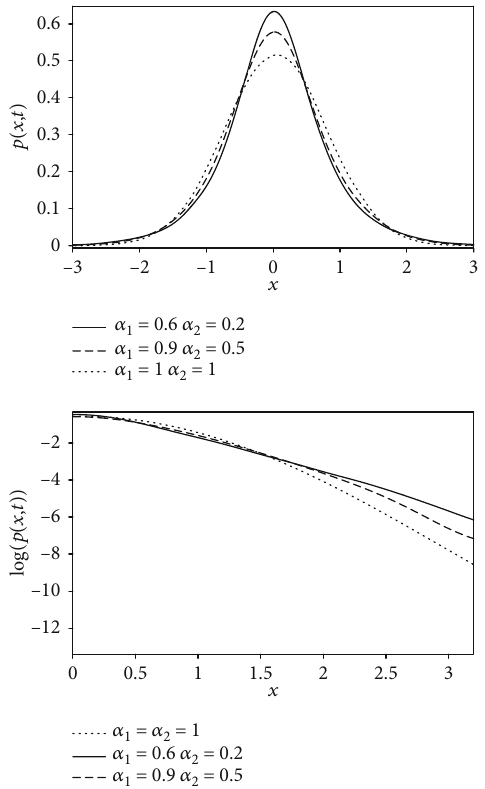
Figure 4: The approximated solutions (up) of Equation (1) with di ff erent α and α are obtained for t = 1 . Noting that we estimate 1 2 5000 times to get these solutions. Below is the corresponding Logarithmic